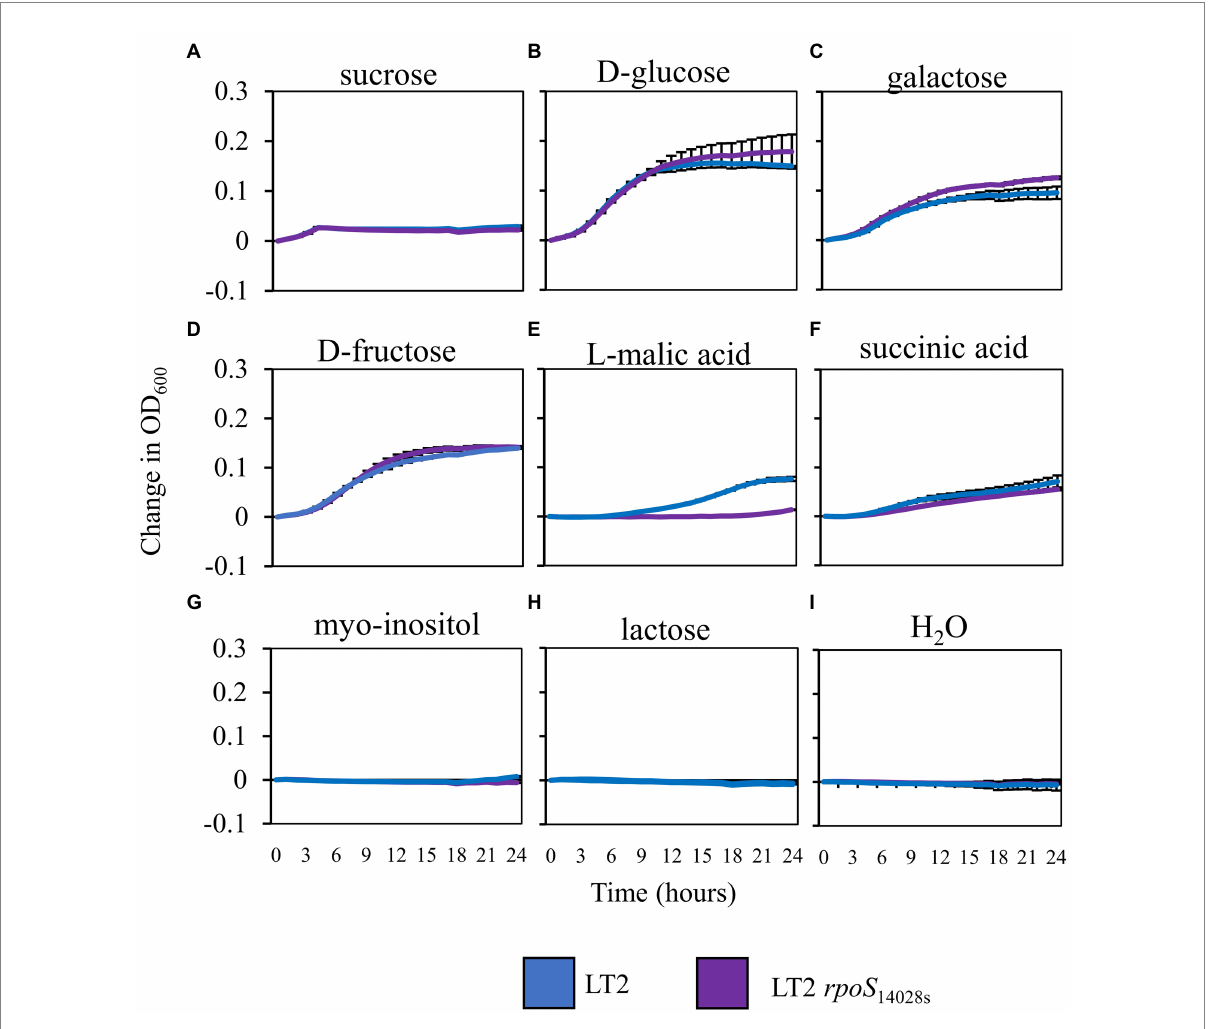
FIGURE 6 Salmonella enterica growth in M9 with NbAWF carbon sources. Growth curves of S. enterica LT2 (blue) and LT2 rpoS 14028s (purple) in M9 medium supplemented with different carbon sources LT2 (blue) and LT2 rpoS 14028s (purple) in M9 medium (A) sucrose, (B) D-glucose, (C) galactose, (D) D-fructose, (E) L-malic acid, (F) succinic acid, (G) myo-inositol, (H) lactose, and mock control (I) H 2 O. Cultures were aliquoted into 4 replicate wells, incubated at 22 ° C, and the OD 600 was recorded hourly. Growth was measured as the average change in measured OD 600 with standard deviation error bars ( n = 4 wells). Two independent experiments were conducted with similar